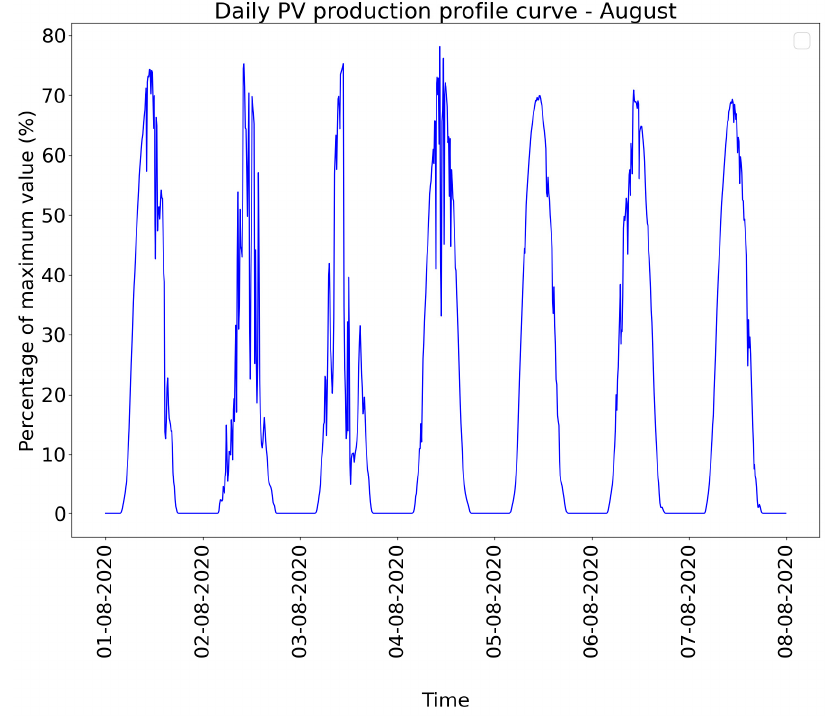
Figure A4. PV production profile curve—August.